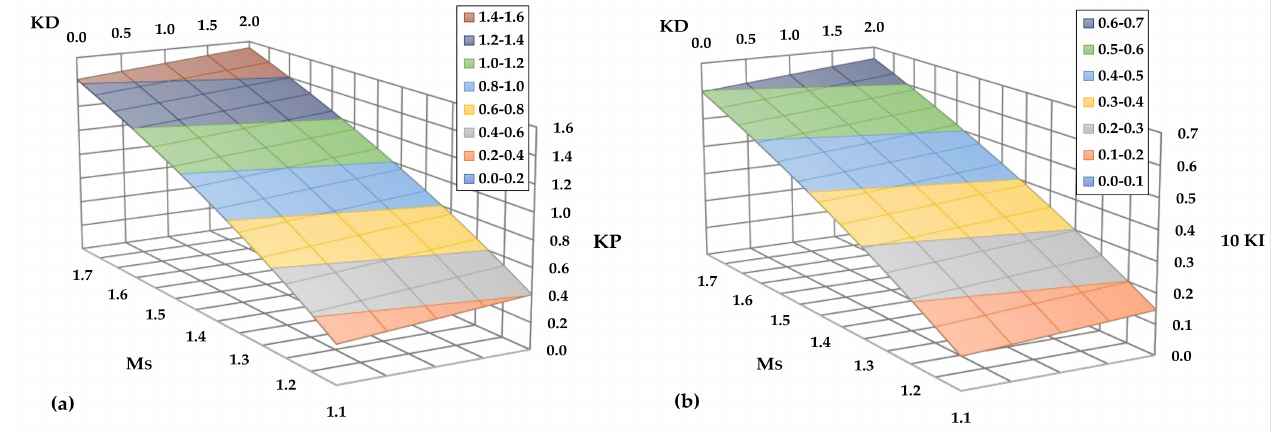
Figure 7. Function between ( a ) k P and M s , k D ; ( b ) k I and M s , k D .